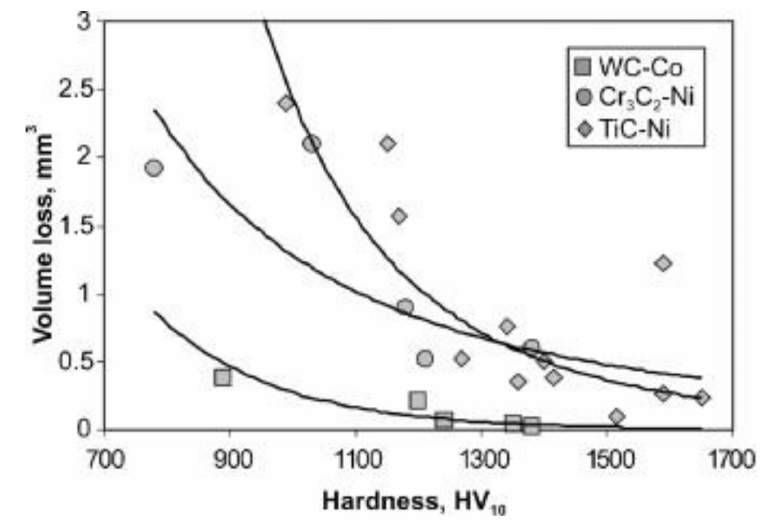
Figure 2. Total wear volume in the two-body dry abrasive wear of the cermets and hardmetals as a function of sliding distance at 20 N load